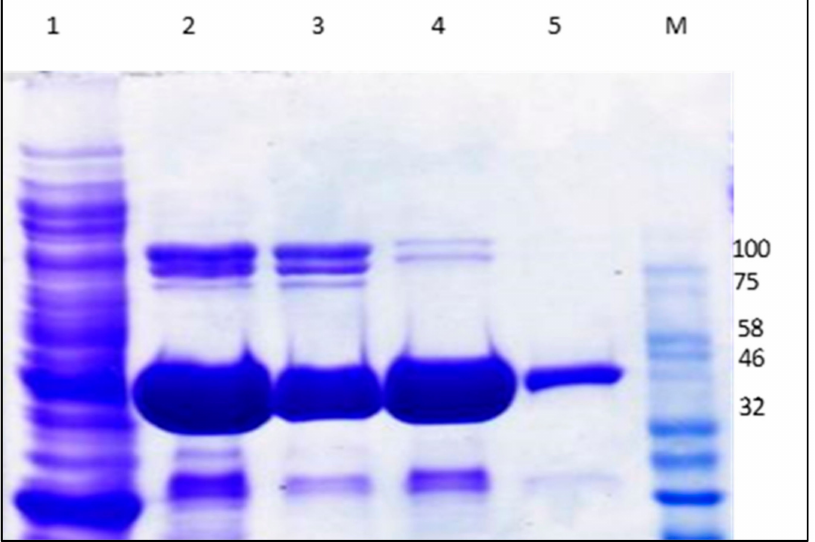
Figure 3. SDS-PAGE profile of the recombinant Ga PIP. Lane 1: Whole-cell protein extract of Ga PIP expressed in E. coli BL21(DE3) STAR; Lane 2: Purified Ga PIP using Ni-NTA; Lane 3–5: Purified Ga PIP using gel filtration chromatography from different elution; M: Protein Marker Broad Range (NEB, Ipswich, MA,